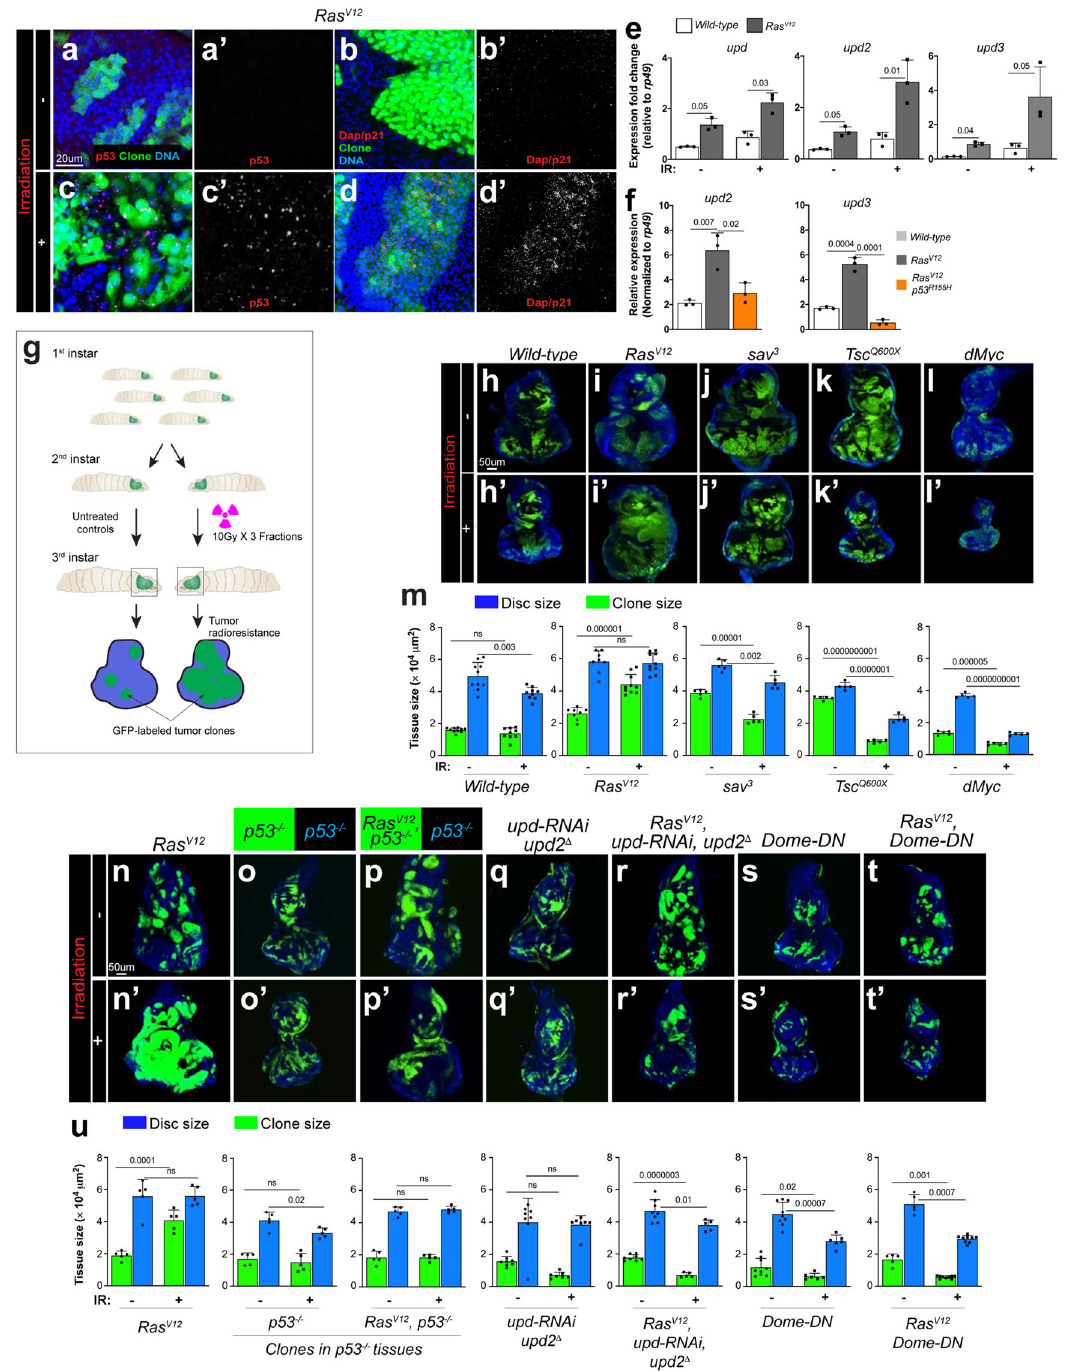
The ptip − / − mutation causes genomic instability in Ras V12 cells, resulting in the upregulation of the dp53 protein. This sti- mulation of p53 is essential for the nonautonomous tissue over- growth effect of Ras V12 ptip − / − tumor clones. RNAi depletion of dp53 in Ras V12 ptip − / − clones abrogates the nonautonomous tissue overgrowth effect. In addition, direct overexpression of dp53 in Ras V12 clones is suf fi cient to trigger overgrowth of the surrounding tissues, mimicking the ptip − / − mutation. The nonautonomous tissue overgrowth effect is mediated by the dp53 transcriptional program. Expression of a DNA